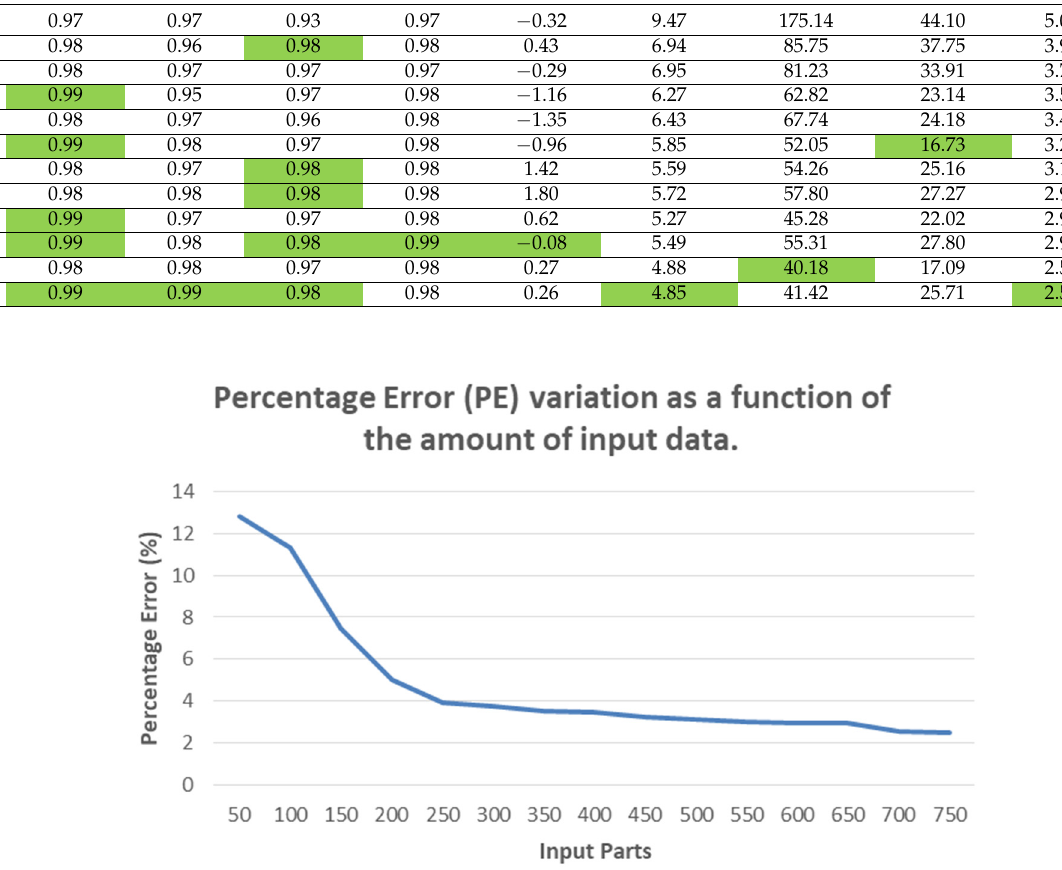
Figure 5. Percentage error (PE) variation as a function of the amount of input data.